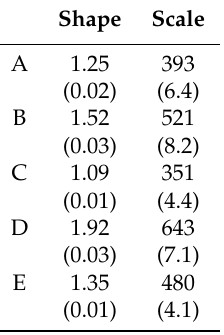
Table 3. Estimates of marginal parameters.